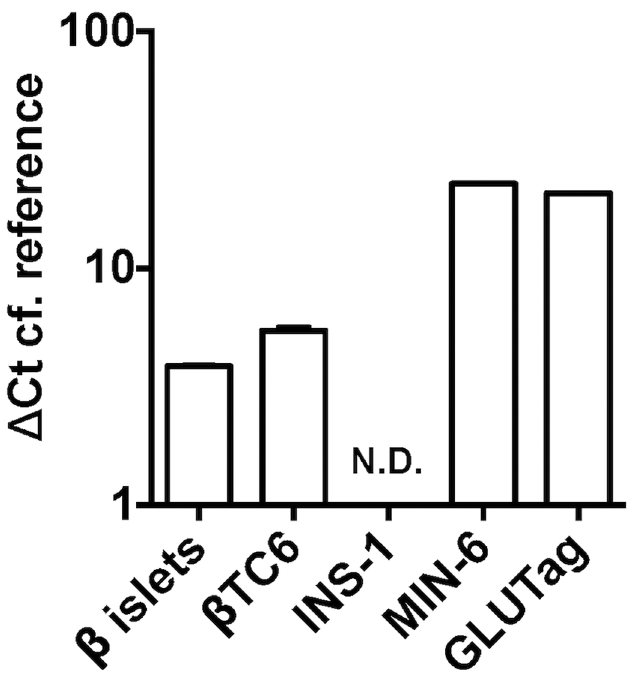
Fig 5. Determination of Gprc6a endogenous expression. Gprc6a mRNA expression in mouse primary islets, murine β -TC6, GLUTag, MIN6 and rat INS-1(832) cells as determined by qPCR or Taqman; N.D. = not